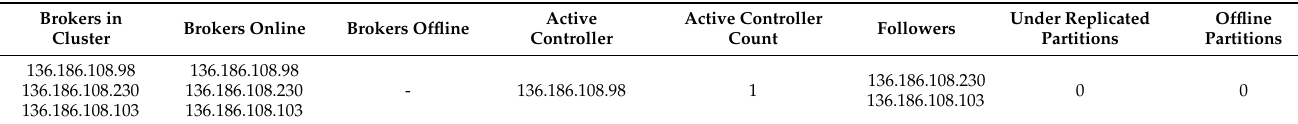
Table 4. Broker and Partition status when brokers are back in to the